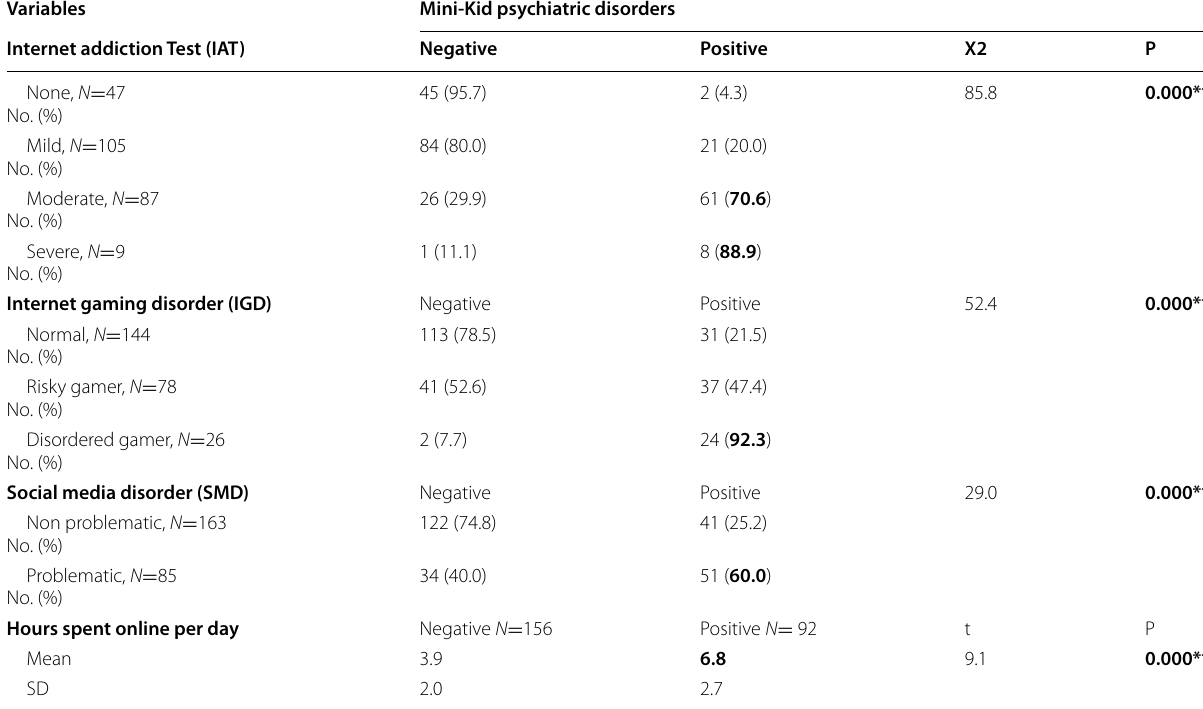
Table 3 Comparison between severity of Internet addiction, Internet gaming disorder, Social media disorder, hours spent online per day, and presence of psychiatric disorders by Mini-kid